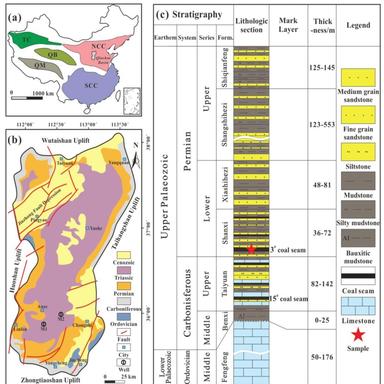
(a) Major cratonic blocks in China and location of Qinshui Basin (NCC = North China Craton, SCC = South China Craton, TC = Tarim Craton, QB = Qaidam Basin, QM = Qiangtang Massif); (b) regional geological map and sampling wells in the Qinshui Basin, modified from; (c) stratigraphy column of the region and sampling horizon.